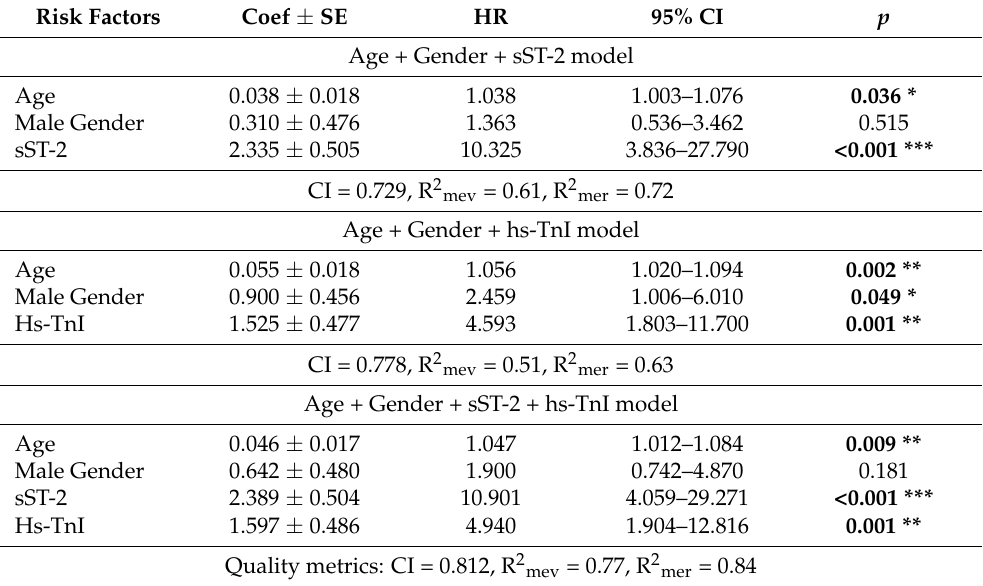
Table 4. Multimarker model for prediction of MACE during follow-up after hospital discharge in COVID-19